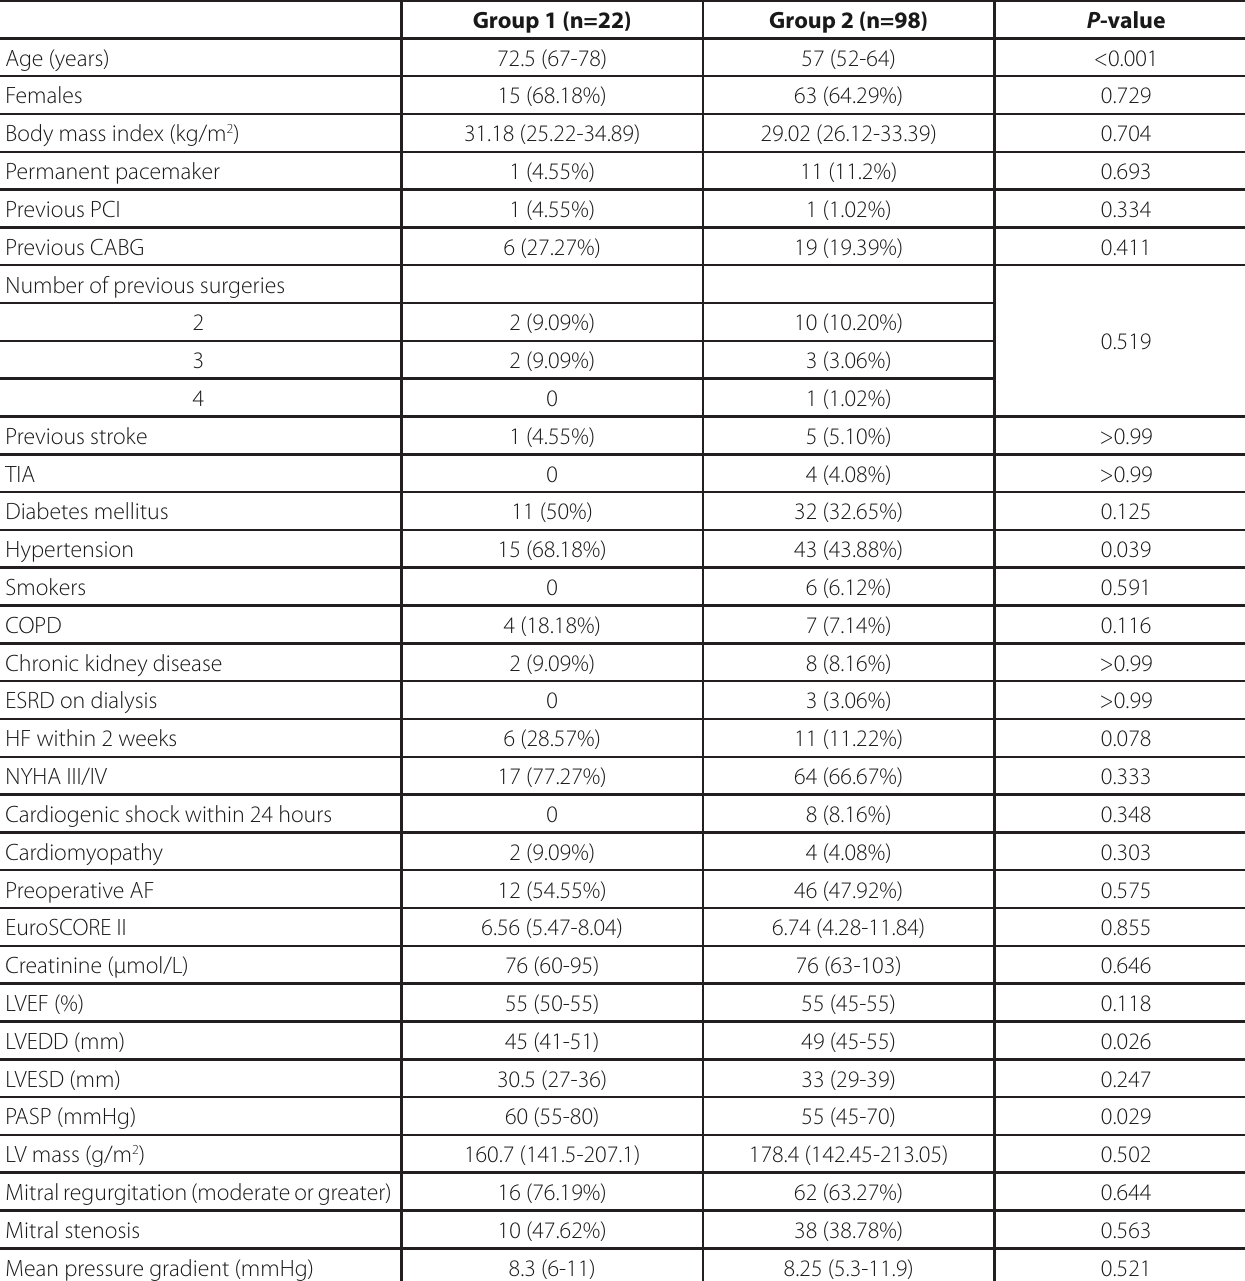
Table 1. Comparison of the preoperative characteristics and echocardiographic data between the two